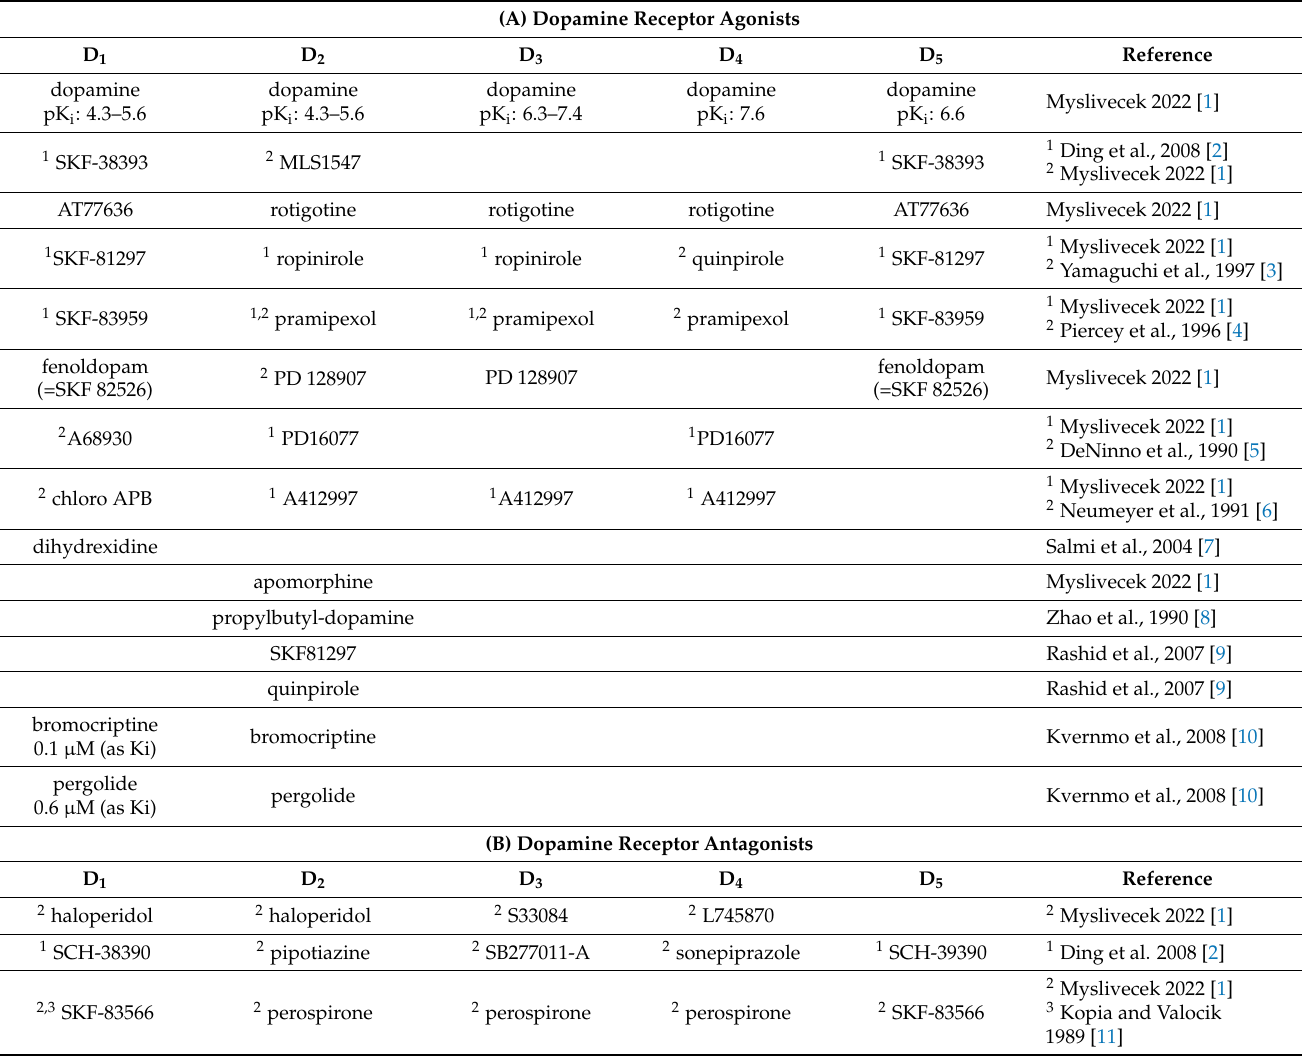
Table 1. ( A ) Dopamine receptor agonists. The main dopamine receptors on which the commonly used dopamine receptor agonist acts are listed here in five columns. Dopamine is an agonist at all dopamine receptors, albeit with varying affinities. One would predict in the heart that first high- affinity dopamine receptors, and thereafter, low-affinity receptors, will be stimulated by dopamine. Note that there is no drug currently available that allows for distinguishing between D 1 -dopamine and D 5 -dopamine receptors. Usually, antagonists do not distinguish between D 2 -, D 3 -, D 4 -dopamine receptors. Moreover, at higher concentrations, for instance, fluphenazine antagonizes also at the D 1 -dopamine receptors. Moreover, antagonists usually are not dopamine receptor-selective. For instance, metoclopramide also acts antagonistically on cardiac 5-HT 4 -serotonin receptors and dom- peridon on cardiac potassium channels. ( B ) Dopamine receptor antagonists. The main dopamine receptors on which commonly used dopamine receptor antagonists act are listed here in five columns. Note that there is no antagonist that is currently available that allows to distinguish between D 1 -dopamine and D 5 -dopamine receptors. Usually, antagonists do not distinguish between D 2 -, D 3 -, D 4 -dopamine receptors. Moreover, at higher concentrations, for instance, fluphenazine antagonizes also at D 1 -dopamine receptors. Moreover, antagonists usually are not dopamine receptor-selective. For instance, metoclopramide also acts antagonistically on cardiac 5-HT 4 -serotonin receptors, and domperidon acts antagonistically on cardiac potassium channels. Superscript numbers indicate which drug was used in which reference. Ki indicates the half maximum concentration to inhibit a function and pKi represents its negative decadic